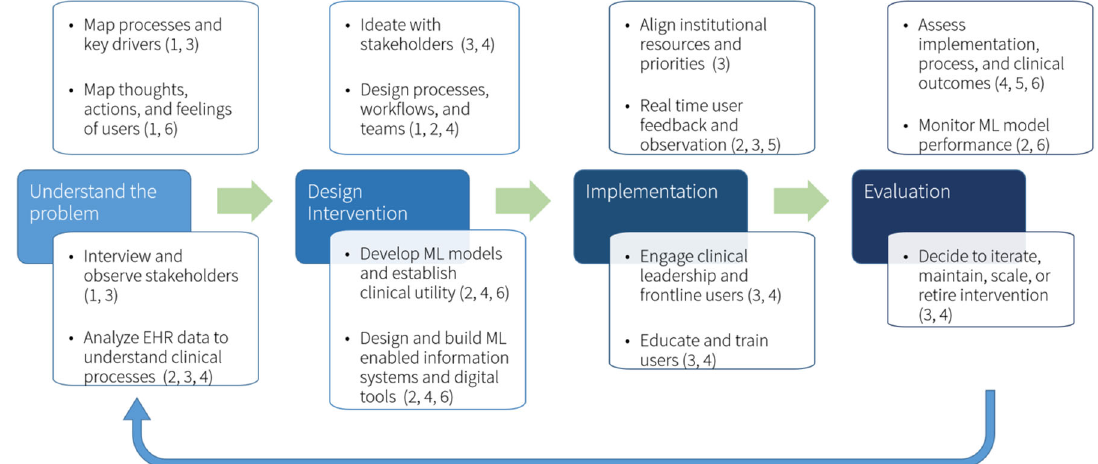
Fig. 1 Multidisciplinary process for creating, implementing, and evaluating an AI enabled system for healthcare. Methods from process improvement, design thinking, data science, information technology, and implementation science are combined into an iterative participatory process to build an AI enabled system for improving advance care planning. The expertize used across the different disciplines are as follows: (1) user experience design, (2) data science, (3) healthcare operations, (4) clinical informatics, (5) evaluation, and (6) ethical integrity